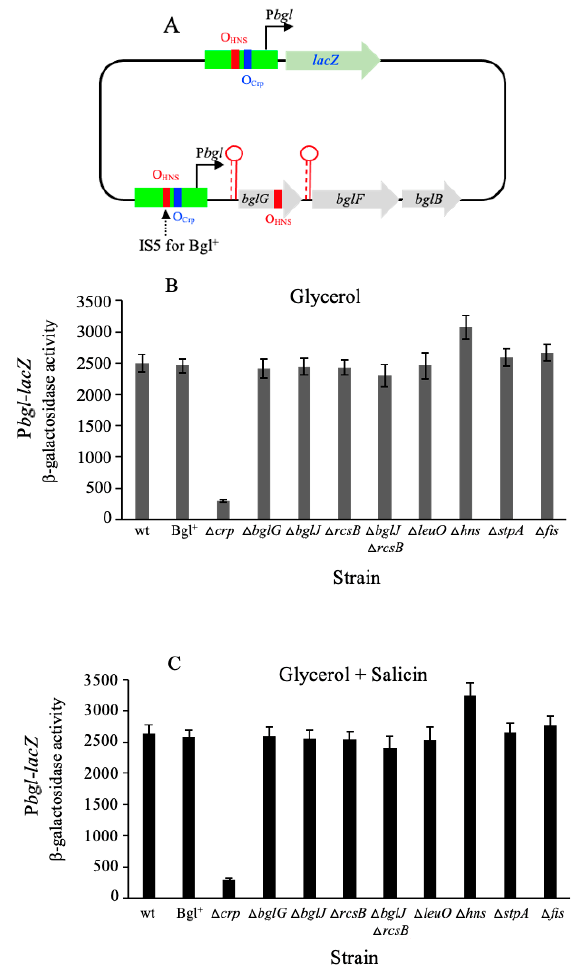
Figure 1. The bgl promoter (P bgl ) activities in the wild type and various isogenic genetic backgrounds. Cells were grown in M63 minimal media with shaking at 37 °C. At least four samples were collected at OD 600 values of 0.2 to 1.0 during the exponential growth phase. Bacterial samples were subject to β -galactosidase assays as described in Section 4, and the enzyme activities were calculated using the equation [(OD 420 − 1.75 × OD 550 )/(sample volume in mL × time in min)] × 1000. For a given test strain, the slope of OD 600 values versus β -galactosidase activities was referred to as the promoter activity. ( A ) Diagram showing the lacZ transcriptional reporter for the bgl promoter (P bgl - lacZ ). P bgl ( − 205 to + 54 relative to the transcriptional start site) with no terminators was fused to the upstream region of the lacZ ’s RBS (that is, to TTTCACACAGGAAACAGCT) at the lac locus, replacing lacI and the lacI / lacZ intergenic region. The native bgl operon remained intact. However, for strain Bgl + , there is an IS5 element oriented in the inverse direction and inserted at − 207.5 upstream of the bglG translation start site. For both the promoter reporter and the native bgl operon, the blue bars represent the Crp binding sites (O Crp ) while the red bars represent the proposed H-NS binding sites (O HNS ). ( B ) P bgl activities in cells grown with glycerol as the primary carbon source. ( C ) P bgl activities in cells grown with glycerol and salicin as carbon